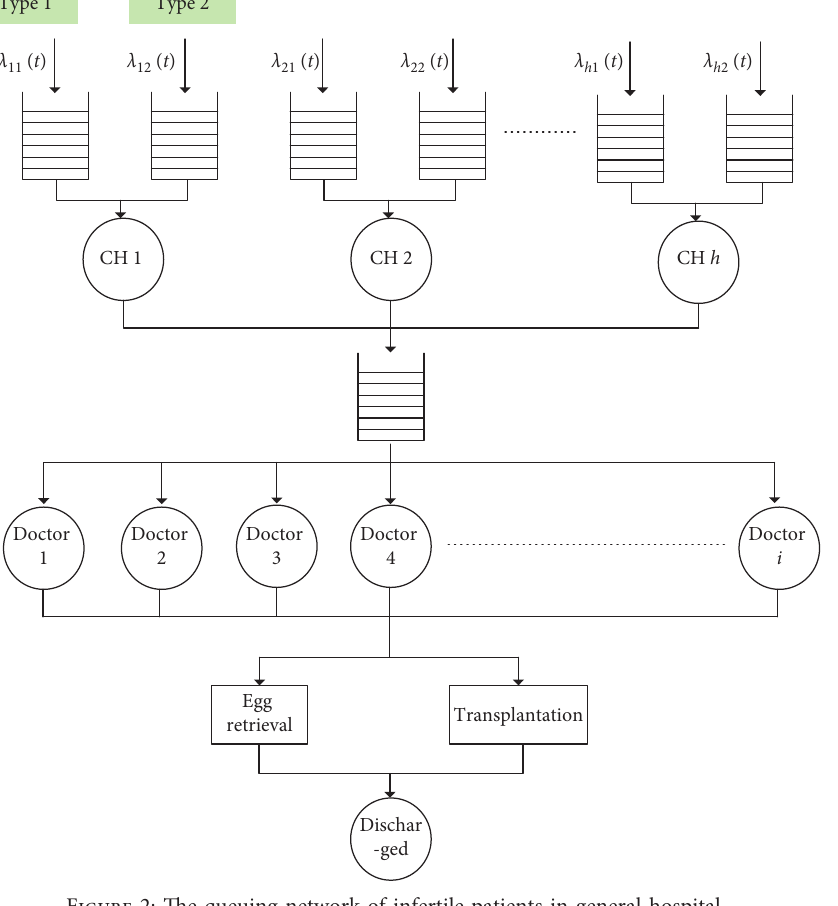
Figure 2: The queuing network of infertile patients in general